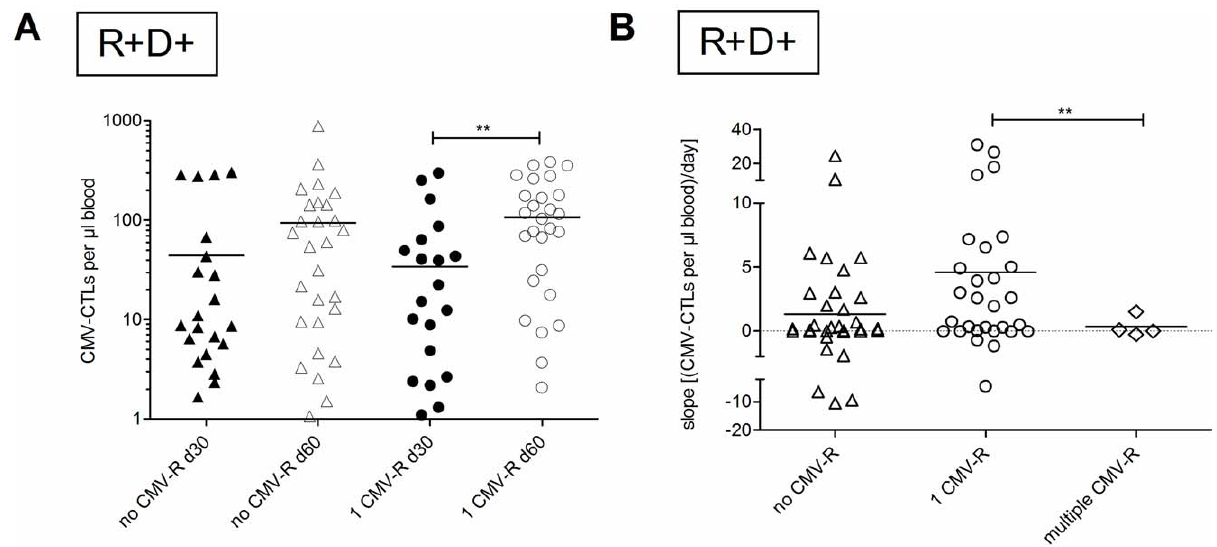
Figure 5. Kinetics of CMV-CTL expansion after CMV reactivation. ( A ) CMV-CTL levels around day + 30 (the interval from day + 15 to + 45 was assessed, filled symbols) and day + 60 (the interval from day + 46 to + 99 was assessed, filled symbols) in patients who experienced (circles) or did not experience (triangles) a CMV reactivation prior to day + 100 in the R + /D + group. Significant differences between groups were assessed by t-test with Welch’s correction, and included the 34 data points not depicted because they lie outside axis limits. ( B ) Patients in the R + /D + group who experienced no (triangles), a single (circles) or multiple (diamonds) CMV reactivations before day + 100 were compared (t-test with Welch’s correction) using the difference between the slopes of the lines created by the CMV-CTL levels during the interval from day + 15 to + 45 and the interval from day + 46 to + 99. The dotted line indicates no change in CMV-CTL level between the measurements in both intervals. ** p # 0.01.